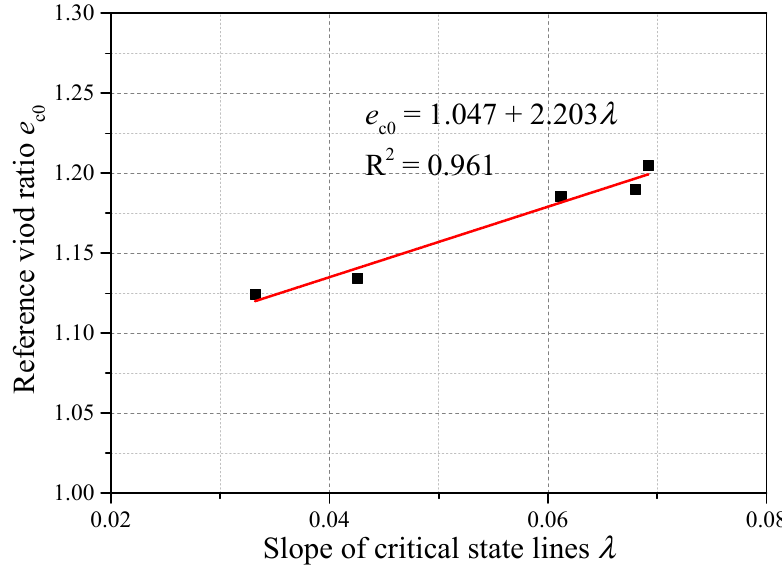
Figure 9. Relationship between reference void ratio e c 0 and slope of critical state lines λ .